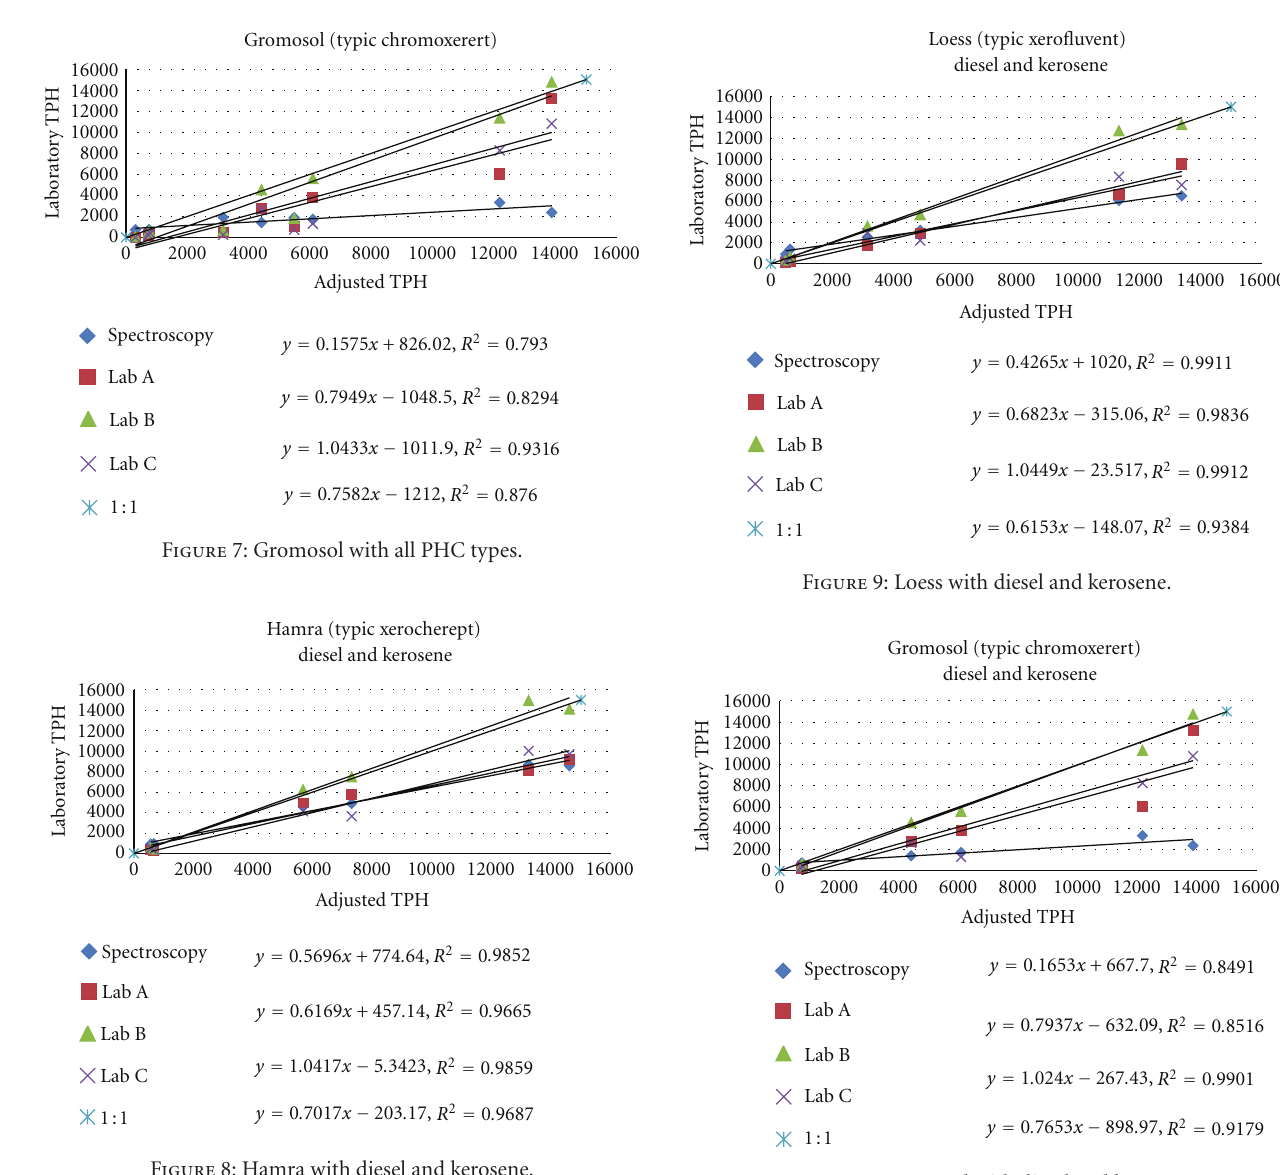
Figure 10: Gromosol with diesel and